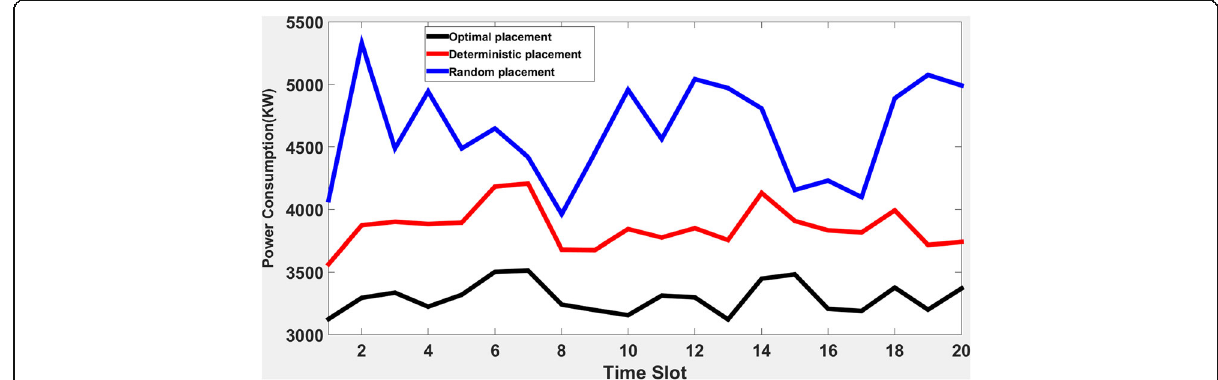
Fig. 7 Optimal power consumption with migration (Gr = 0.3) together with deterministic and random heuristics as a function of